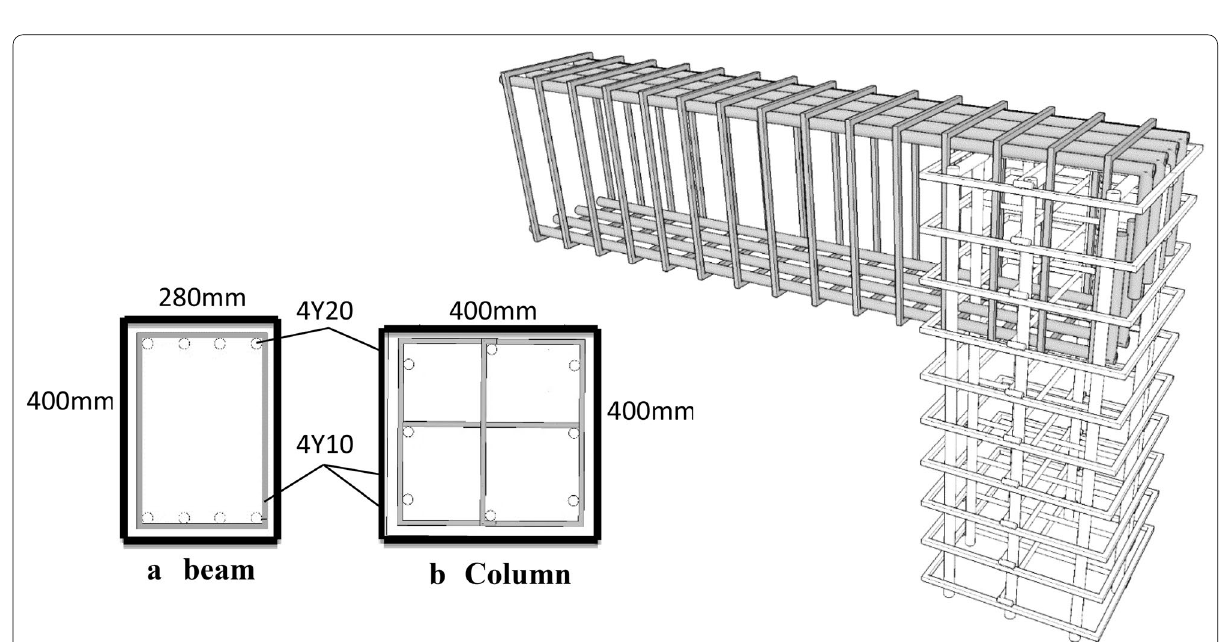
Fig. 4 Steel reinforcements layout with reinforcement cross